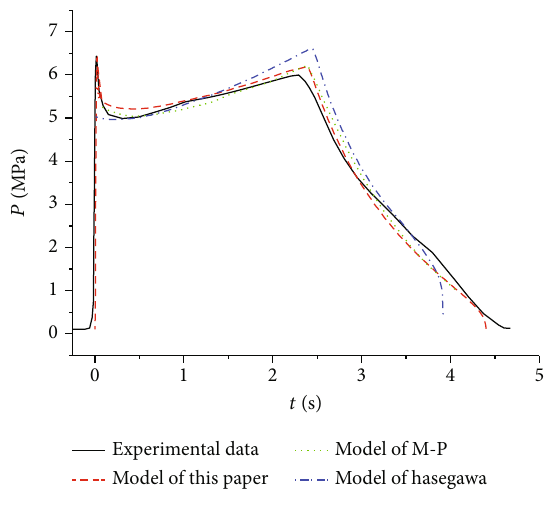
Figure 12: Pressure history of motor